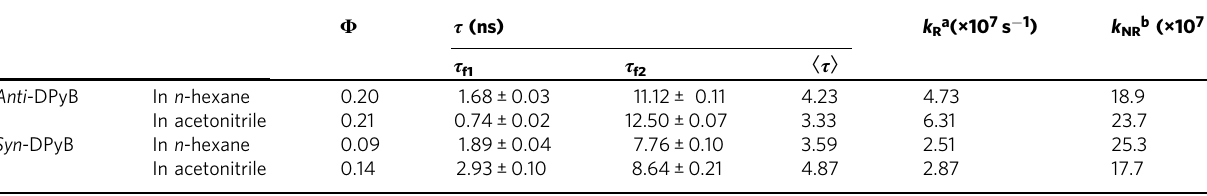
Table 1 Emission quantum yields ( Φ ), emission lifetimes ( τ ), average emission lifetimes ( 〈 τ 〉 ), radiative rate constants ( k R ), and nonradiative rate constants ( k NR ) of Anti -DPyB and Syn -DPyB in n -hexane and acetonitrile.